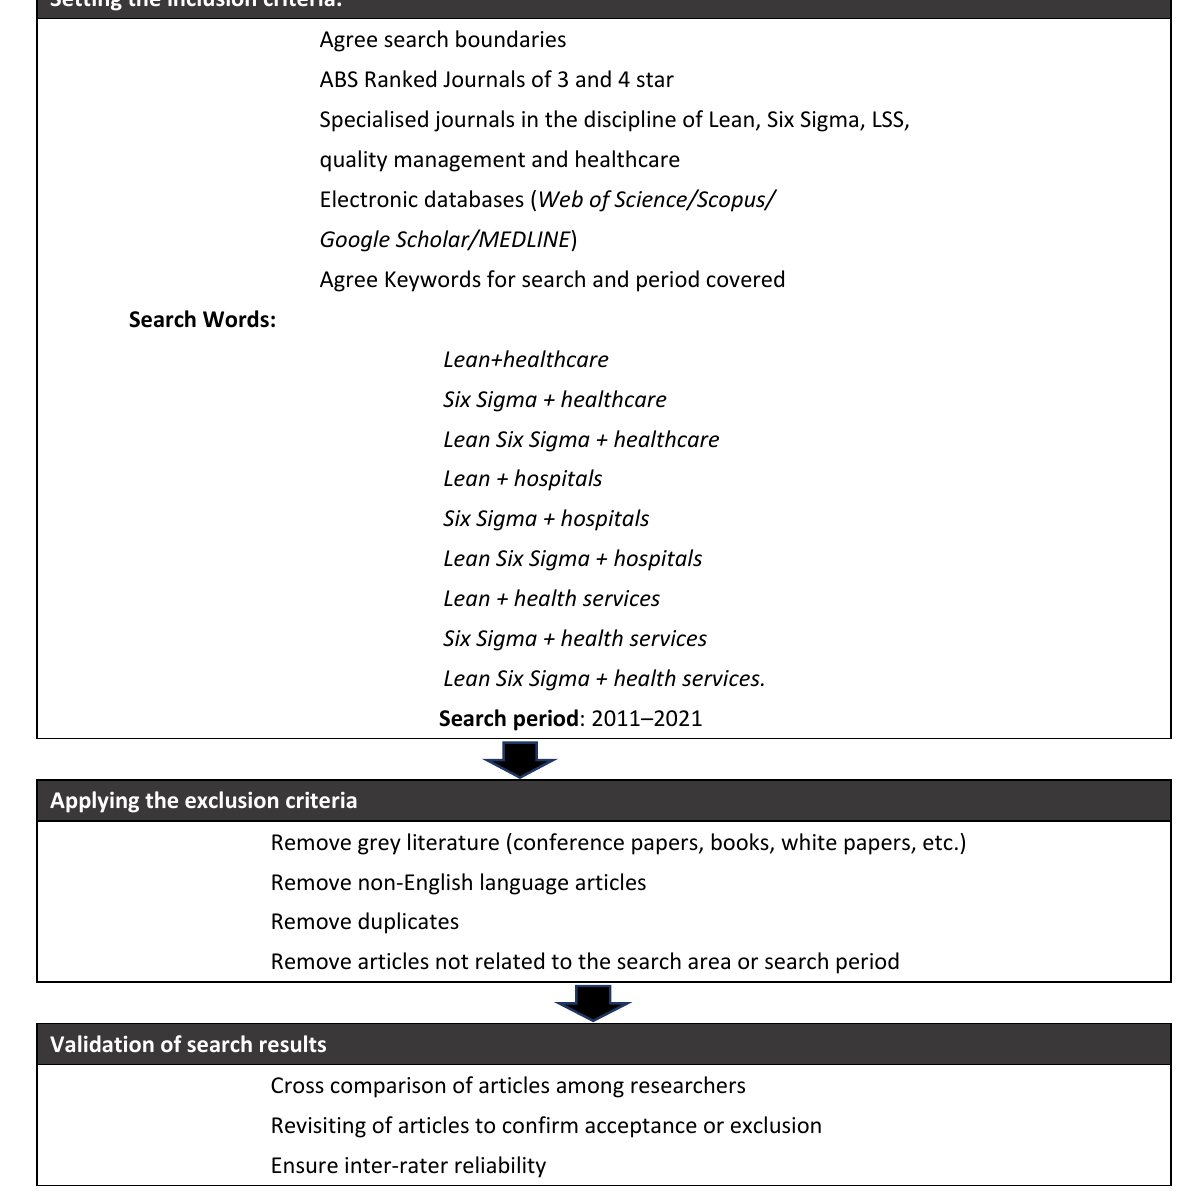
Figure 1. SLR Research Methodology Flow Chart with Inclusion and Exclusion Criteria. Flowcharts within SLRs ensure and improve review transparency [18], and a flowchart was utilised to draw out and map the steps within the SLR process (Figure 1). In addition, the flowchart allows future researchers to follow, replicate and draw